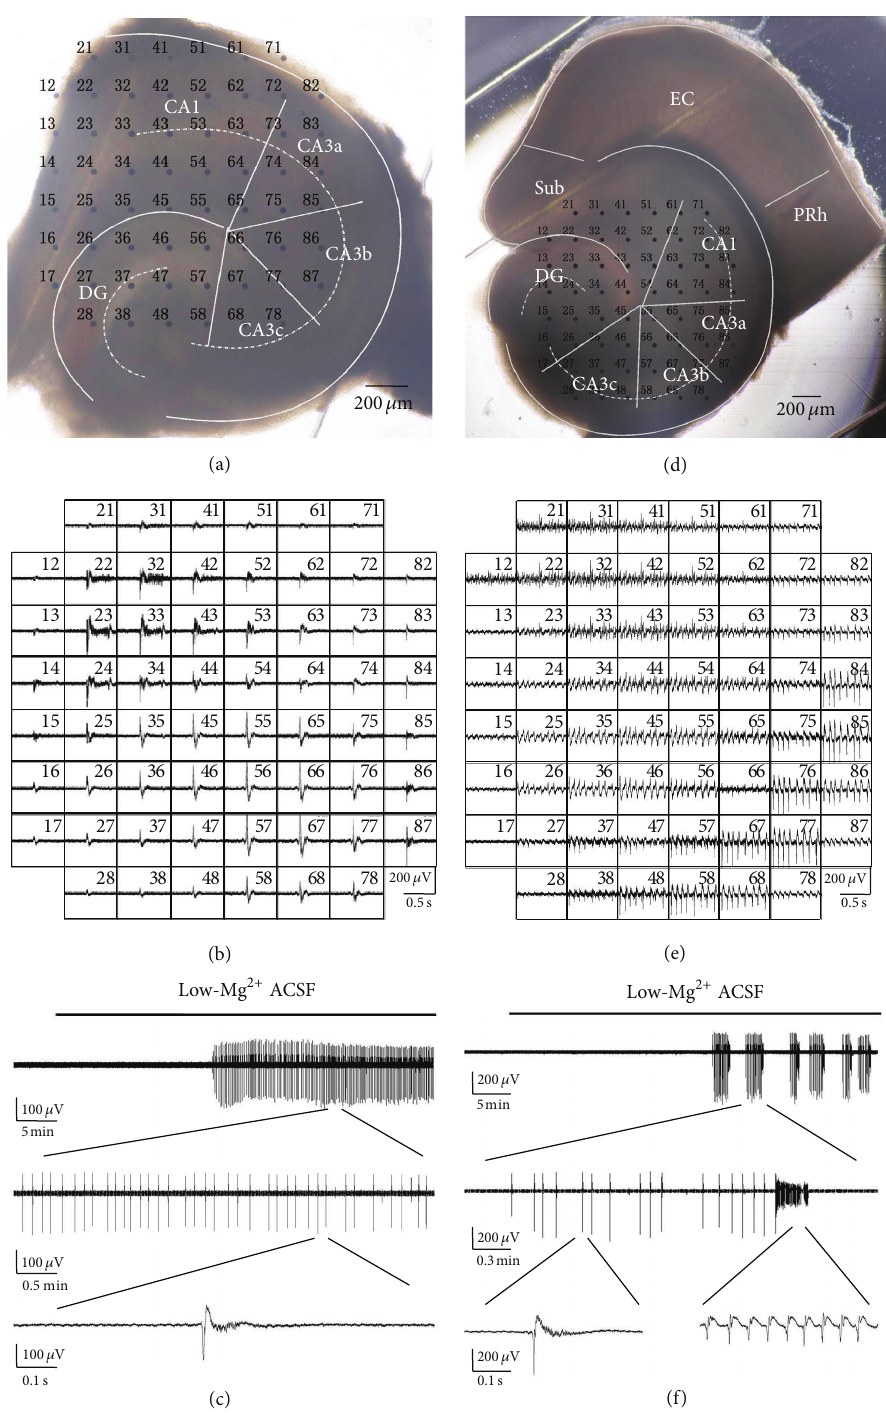
Figure 1: Slices mounted on MEA and low-Mg 2+ -induced epileptiform discharges. (a) An image of an example of a hippocampal slice mounted on MEA. The black dots indicate the electrodes (60 channels) of the MEA, with each electrode number labeled at its top left corner. (b) Low-Mg 2+ -induced epileptiform discharges recorded by the MEA. Each data window represented the recording from one electrode, with each electrode number labeled at its top right corner. (c) A portion of raw data recorded by one electrode (number 87), which showed epileptiform discharges in the CA3b region, with epileptiform activities presented using different time scales. (d) An image of an example of combined EC-hippocampal slice mounted on MEA. (e) Low-Mg 2+ -induced ictal discharges recorded by the MEA. (f) A portion of raw data recorded by one electrode (number 67), which showed epileptiform discharges in the CA3b region of the combined slice. There were two types of epileptiform discharges recorded in the hippocampal area: interictal and ictal discharges. Each discharge cycle consisted of several minutes of interictal discharges and tens of seconds of ictal discharge. After a resting period, this alternating interictal and ictal discharge pattern